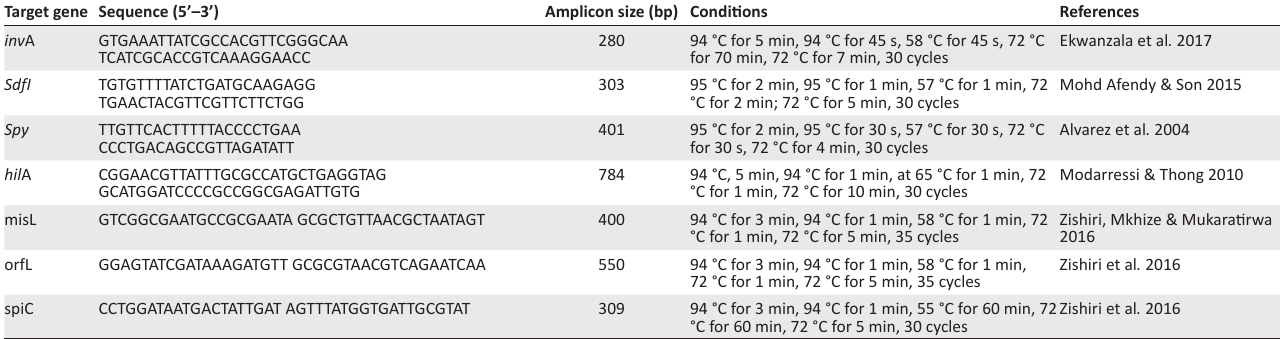
TABLE 1: Primers sequences, source of primers for amplification and polymerase chain reaction conditions used for in this study. Target gene Sequence